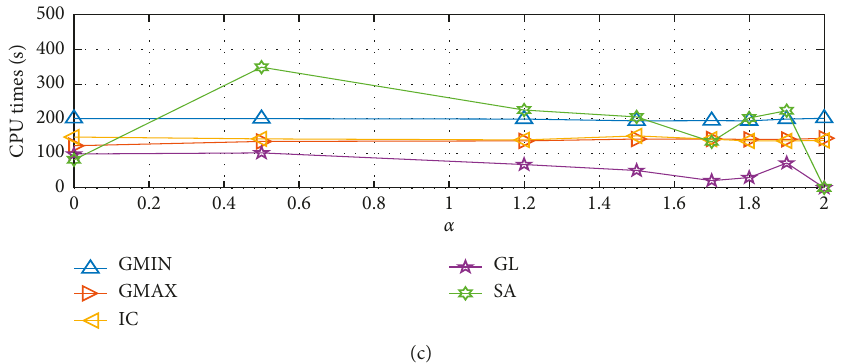
Figure 6: (a) Upper bounds, (b) number of facilities, and (c) CPU times in seconds for the instance #10 in Table 9 while varying α ∈ [ 0 ; 2 ] and using a radial coverage value of 0.2km.